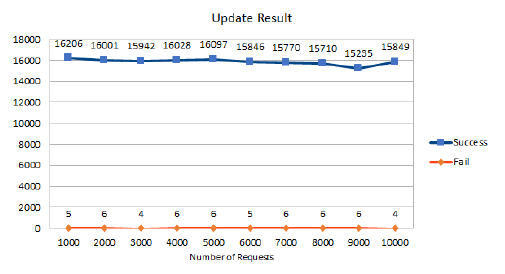
Figure 6. The results of the update data